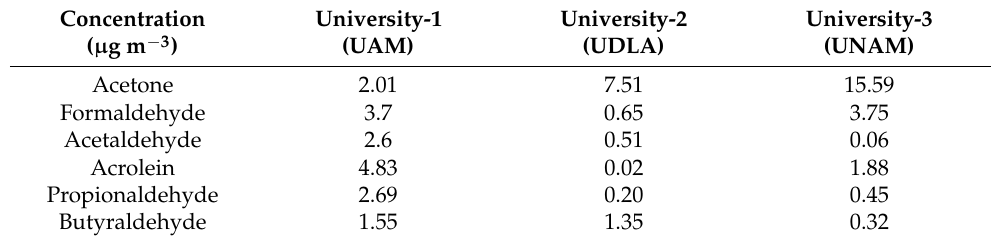
Table 8. The indoor/outdoor (I/E) concentration ratios of the carbonyl compounds for each sampling site.